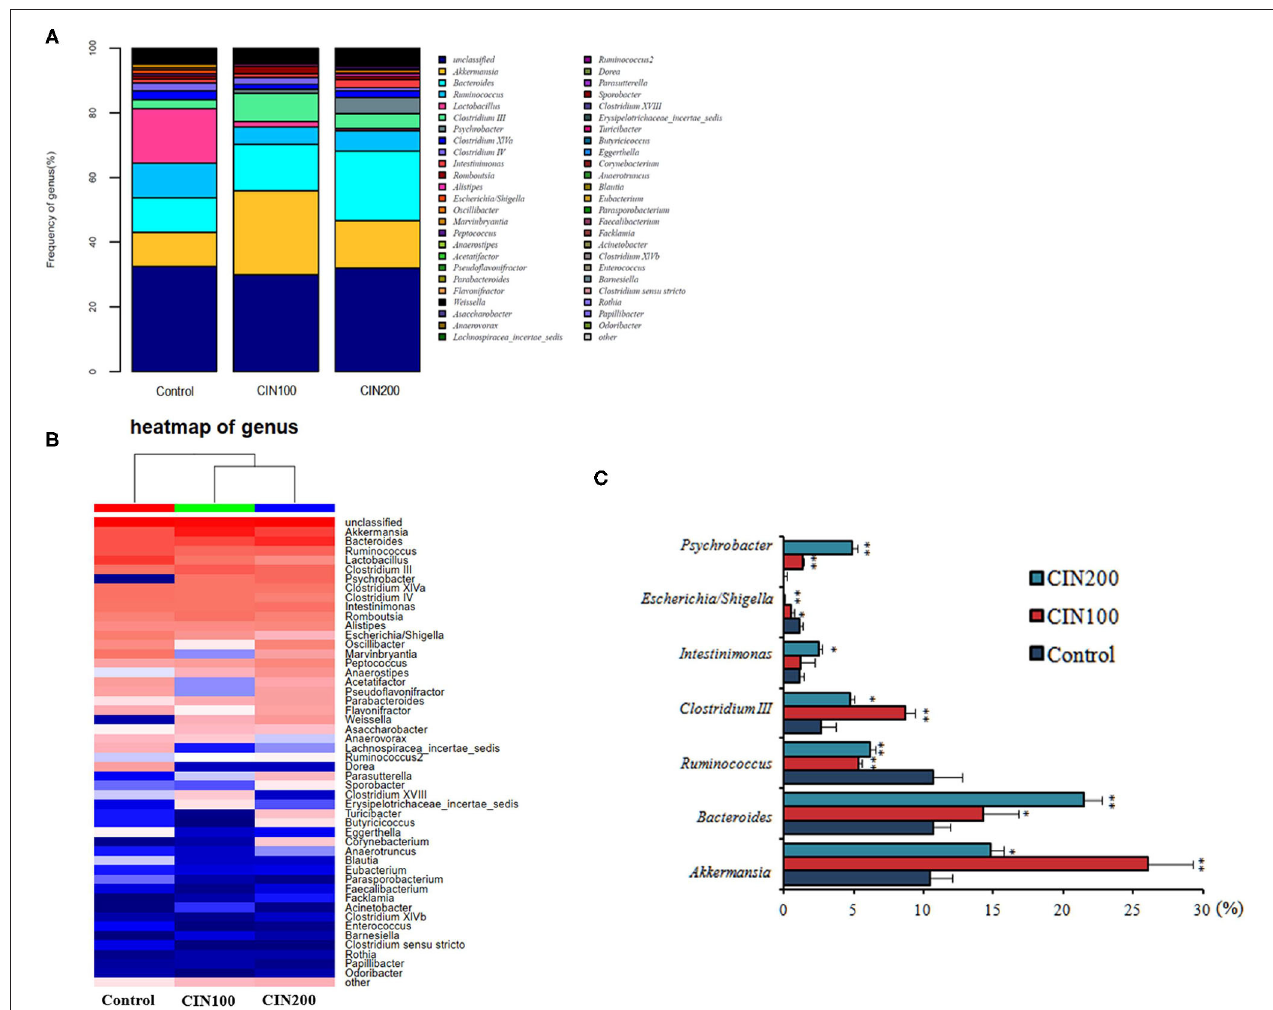
FIGURE 7 | Effects of cinnamaldehyde supplementation on the abundance of intestinal bacteria at genus level. (A) The relative abundance of the intestinal bacteria at the genus level. (B) Heatmap of genus. (C) The relative abundances of the top seven most abundant microbial genera across all samples. * P < 0.05 and ** P < 0.01. One-way ANOVA was carried out for each comparison with HSD